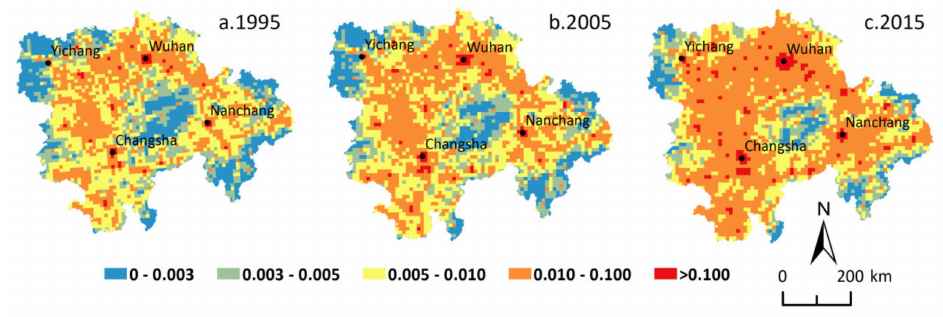
Figure 3. Spatial distribution of urbanization level in the Middle Reaches of the Yangtze River Urban Agglomerations at 10 km grid scale. Note: Reprinted with permission from Chen et al. (2020). Copyright 2020 China University of Geosciences